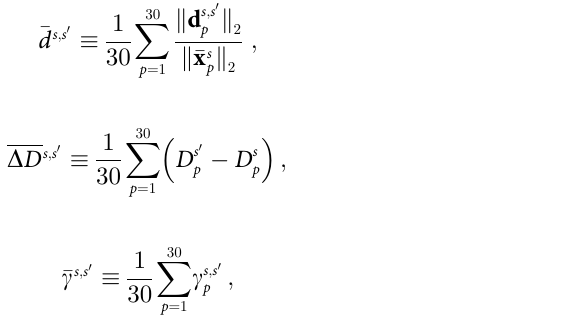
This quantity is plotted with its corresponding Δ t and then fitted using linear regression. Error bars for all linear regression plots throughout this work are generated by computing the 95% confidence intervals for the slope and intercept separately, and then filling in all linear fits that lie between the extreme ends of said intervals. Fig 2f, 2g and 2h are all computed similarly, the drift metric for a given division is computed and then, for each mouse and separate instance of drift, the quantity is averaged over all 30 stimulus groups. In particular, the quantities plotted in Fig 2f, 2g and 2h are respectively